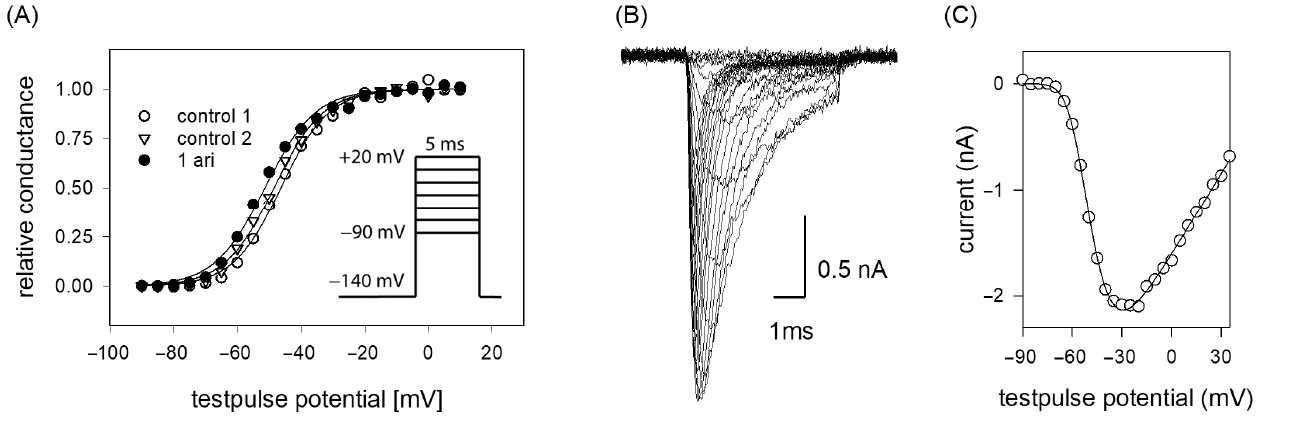
Figure 3. ( A ) Voltage dependence of activation. The graph illustrates representative data obtained from one typical cell. Normalized peak conductances in the absence (control 1 and 2; open circles and triangles) and presence of 1 µ M aripiprazole (filled circles) versus test pulse potential are shown. The potential difference in activation midpoints between control 1 and 2 was taken into account as the drug-independent shift. Altogether, mean half-maximal activation for control 1 and 2 occurred at –43.6 ± 3.0 mV and − 45.2 ± 3.4 mV with a mean slope of 6.5 mV. The corresponding values in the presence of 1 µ M aripiprazole were − 46.5 ± 4.2 mV, slope 6.7 mV. Insert: Experimental scheme.